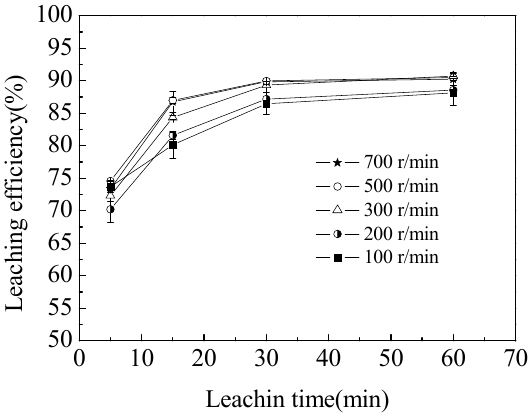
Figure 2. Leaching rate of semi-oxidized manganese ore at different stirring speeds. The data points represent the average values from the triplicate experiments and the error bars represent the 95% confidence limits (Cls).